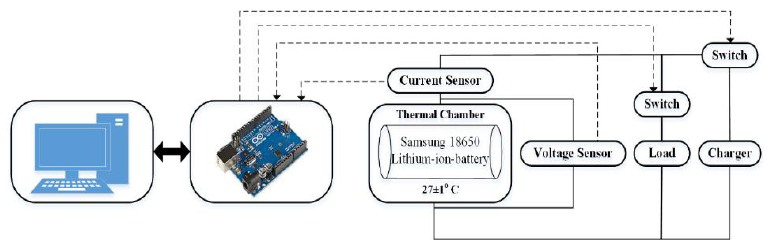
Figure 5. Schematic diagram of the experimental setup.